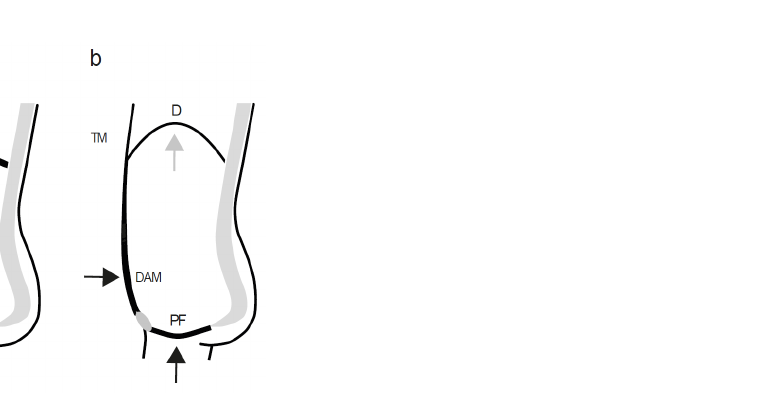
Figure 1. A schematic representation of a mid-sagittal view through the abdominal cavity to demon- strate the opposite orientation and contractile muscle state but parallel downward ( a )/upward ( b ) movement of the thoracic and pelvic diaphragm where the body cavities widen and narrow during quiet breathing at rest. D = thoracic diaphragm, PF = pelvic floor, DAM = deep anterolateral abdominal muscles, TM = thoracic muscles. The thicker lines indicate a muscle contraction and the thinner lines indicate a muscle relaxation. The black arrows indicate an active force vector and the grey arrows indicate a passive force transmission.